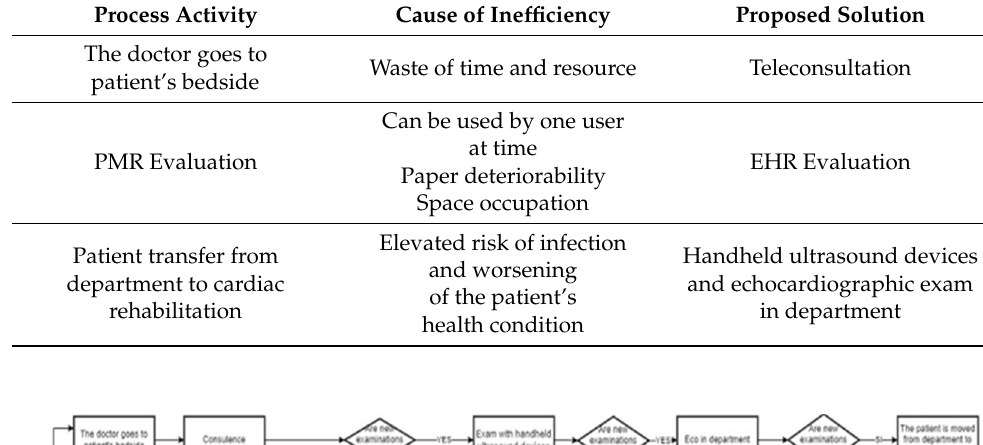
Table 1. Causes and proposed solutions to improve the process.